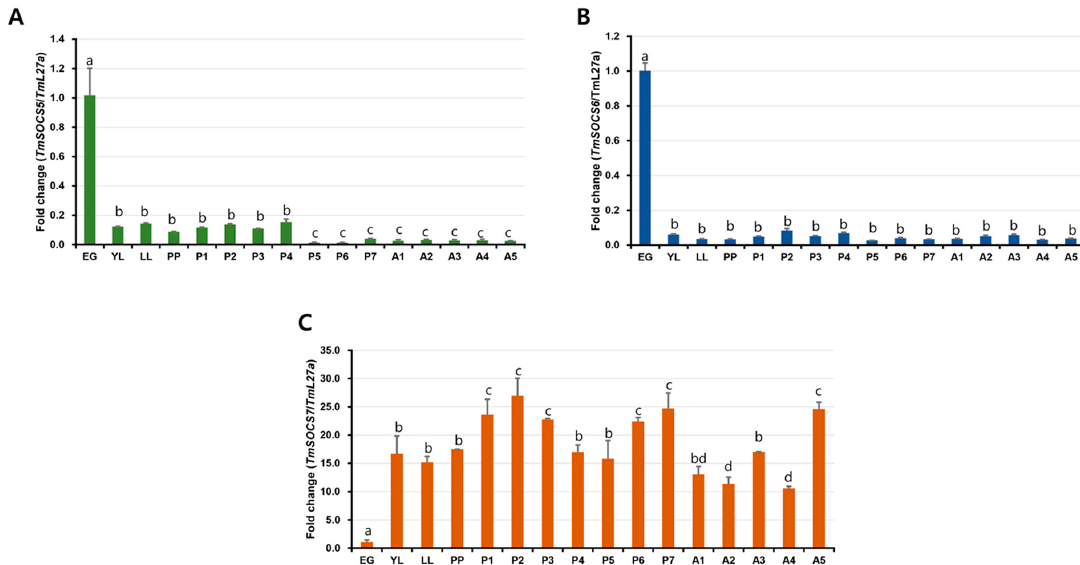
Figure 8. Developmental expression patterns of ( A ) SOCS5, ( B ) SOCS6, and ( C ) SOCS7 transcripts in T. molitor . Relative expression of SOCS mRNA in the egg (EG), early larval (YL), late larval (LL), day 1–7 pupal (P1–P7), and day 1–5 adult (A1–A5) stages Transcript levels were analyzed by